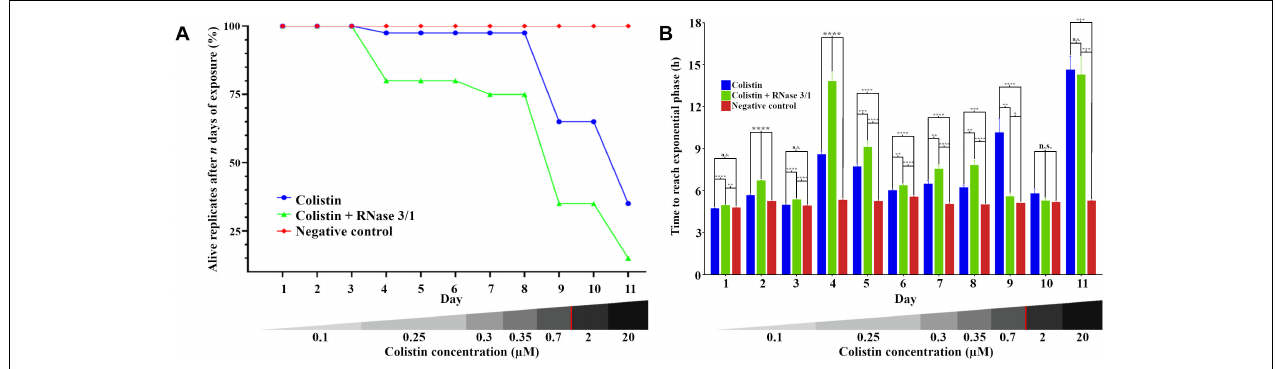
FIGURE 6 | Evolution of the resistance acquisition of A. baumannii to colistin in the presence and absence of RNase 3/1. (A) Graphical representation of the surviving replicates after each day of exposure. (B) Graphical representation of the time needed for the surviving bacteria upon treatment to reach exponential phase (OD 600 = 0.4). The remaining alive replicates are indicated following each day of exposure. Significance is calculated between the different conditions of the same day; n.s. means no significance between the compared samples, ∗ p < 0.05, ∗∗ p < 0.01, ∗∗∗ p < 0.001, and ∗∗∗∗ p < 0.0001 are indicated. The bottom red line indicates the calculated MIC of the colistin